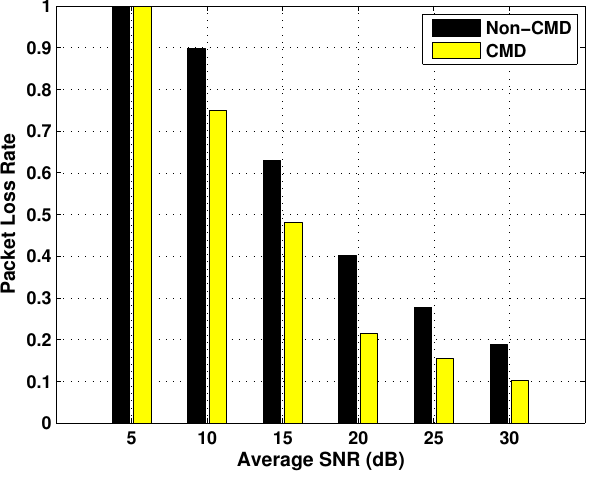
Figure 6. Packet loss rate for High ED nodes, as a function of the average SNR.